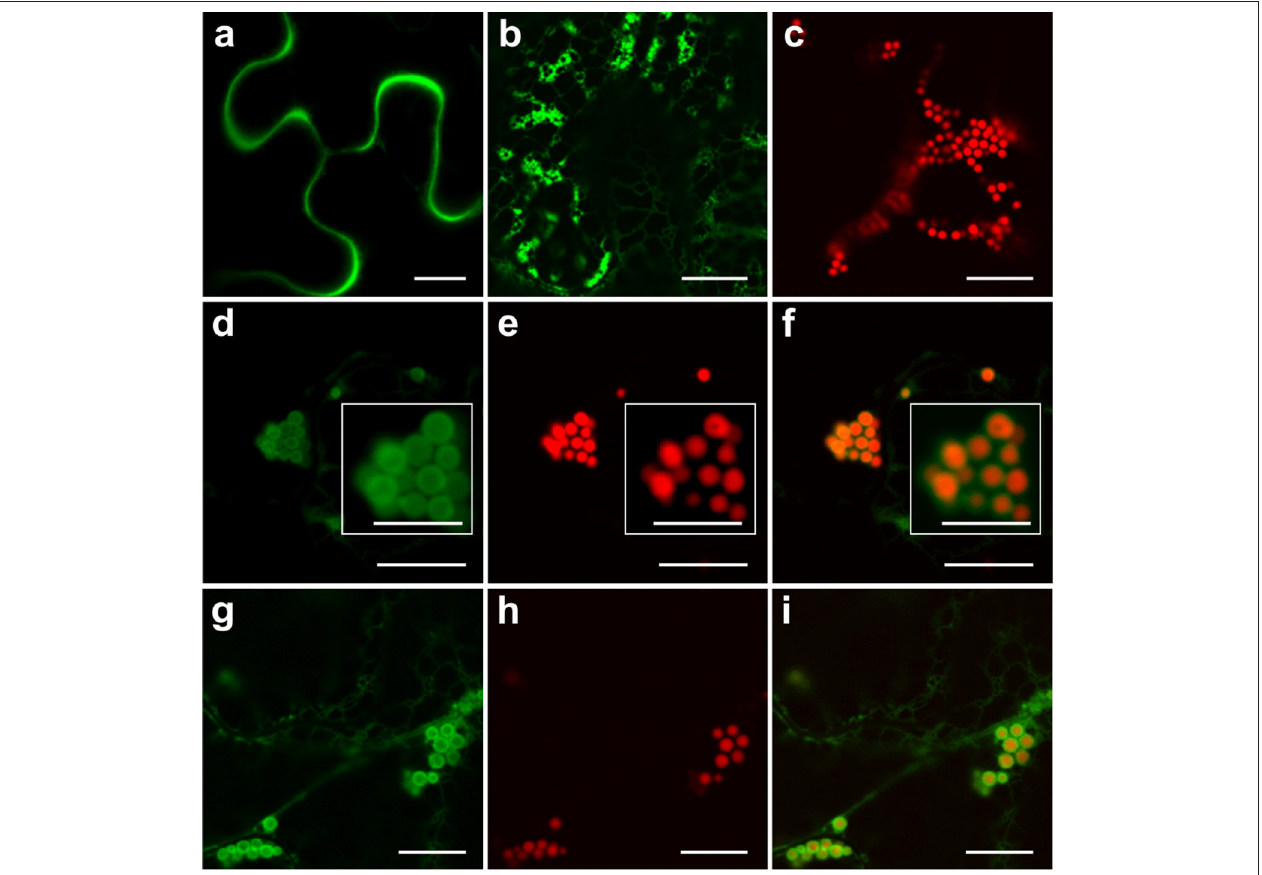
FIGURE 1 | Secretory and endoplasmic reticulum-targeted GFP are sequestered in Zera-induced PBs. (A) Secretory GFP highlights the apoplast between cells. (B) ER-targeted GFP forms small PBs along the ER network. (C) Zera-DsRed induces the formation of PBs. (D–F) Co-expression of secretory GFP and Zera-DsRed results in localization of secretory GFP to the periphery of Zera-DsRed PBs. White boxes show close-ups of the PB cluster. (G–I) Co-expression of ER-targeted GFP and Zera-DsRed results in localization of GFP to the periphery of Zera-DsRed PBs. All images were acquired at 4-dpi in sequential mode. Bar, 10 and 5 µ m in white boxes (D–F).